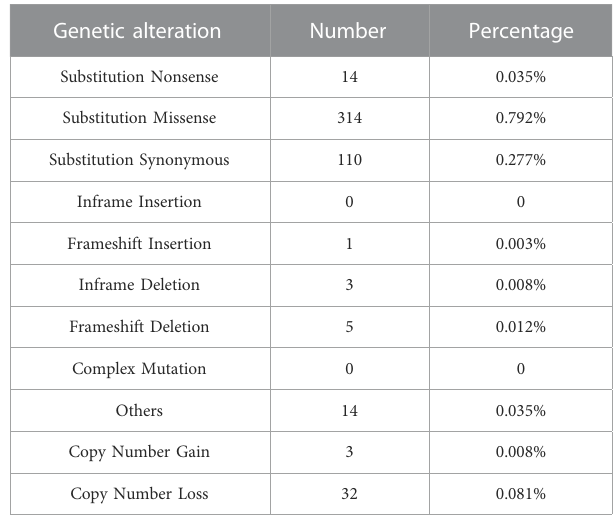
TABLE 1 Genetic alterations affecting CHAF1A in 39,615 cancer samples (COSMIC